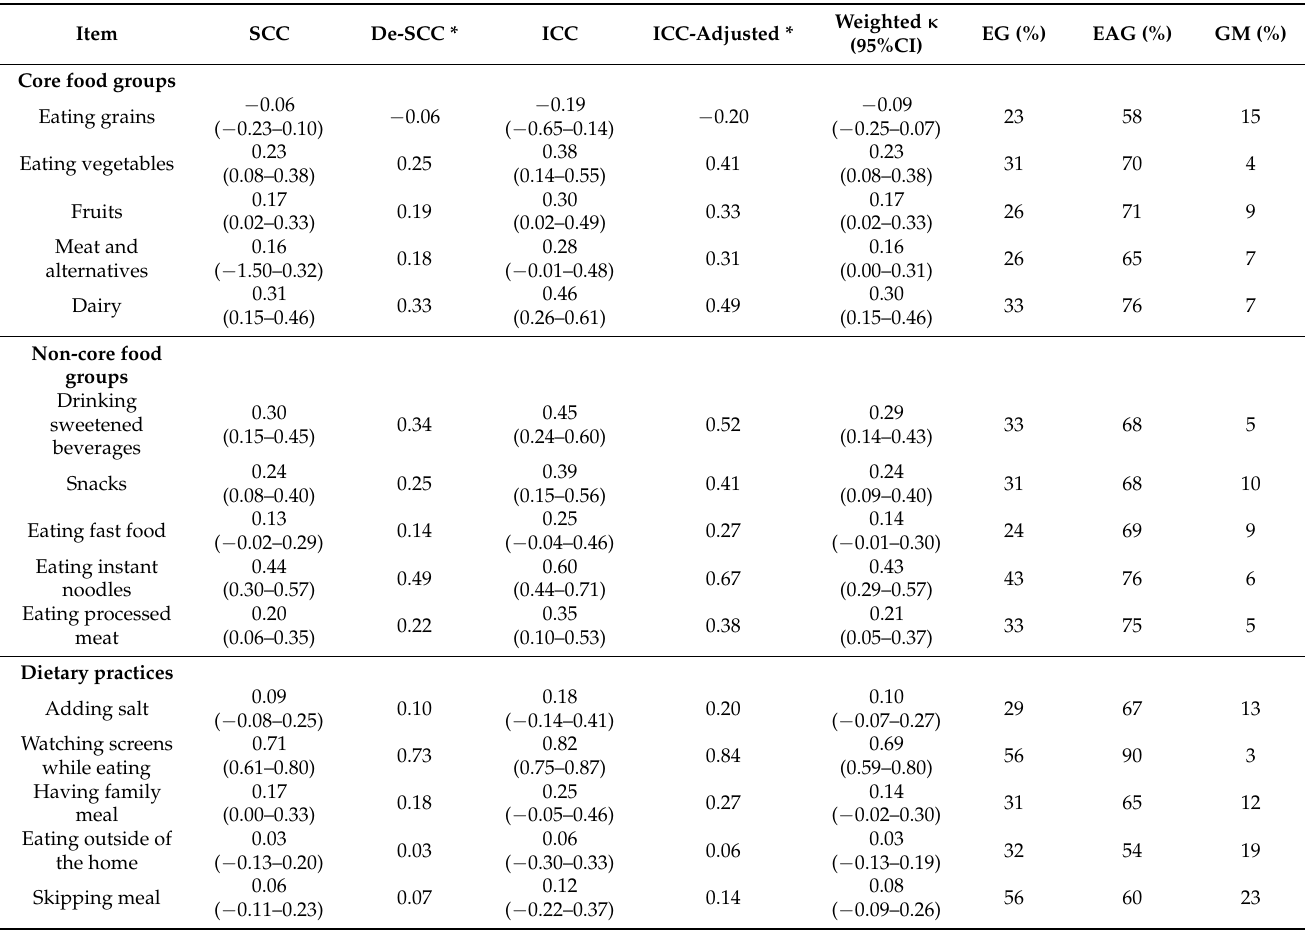
Table 5. Relative validity of the VCSDQ against 24 h recalls ( n =